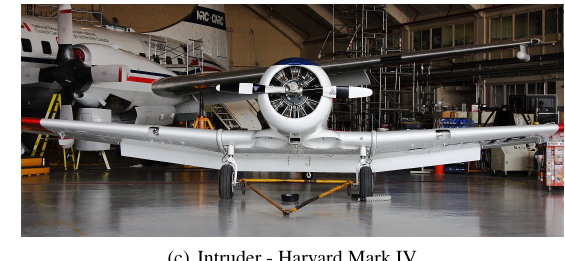
Figure 3: Host and intruder aircraft used for airborne near- collision flight tests.